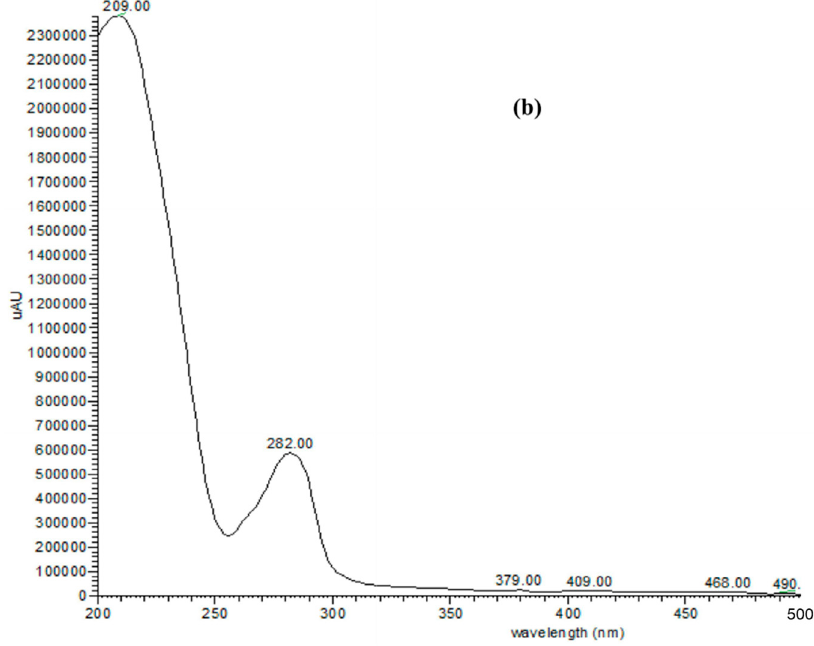
Figure 1. ( a ) HPLC-ESI ( − )-MS/MS profile of a methanol extract of T. fischeri bark; ( b ) A sample spectra (UV) of compounds ( 3 – 20 ) at 280 nm. Table 1. Tentative identification of secondary metabolites of a methanol extract of T. fischeri bark using HPLC-PDA-MS/MS in the negative ion mode.